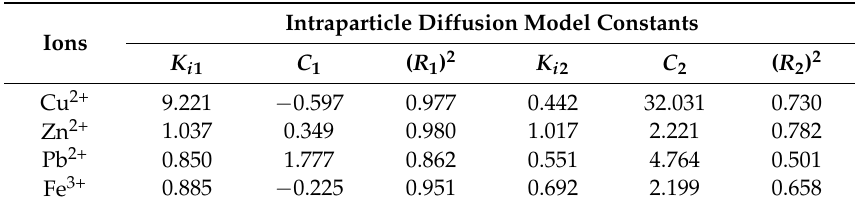
Table 2. Intraparticle diffusion constants and correlation coefficients for the adsorption of Cu 2+ , Zn 2+ , Pb 2+ , and Fe 3+ ions on IIP/Mt nanocomposite.